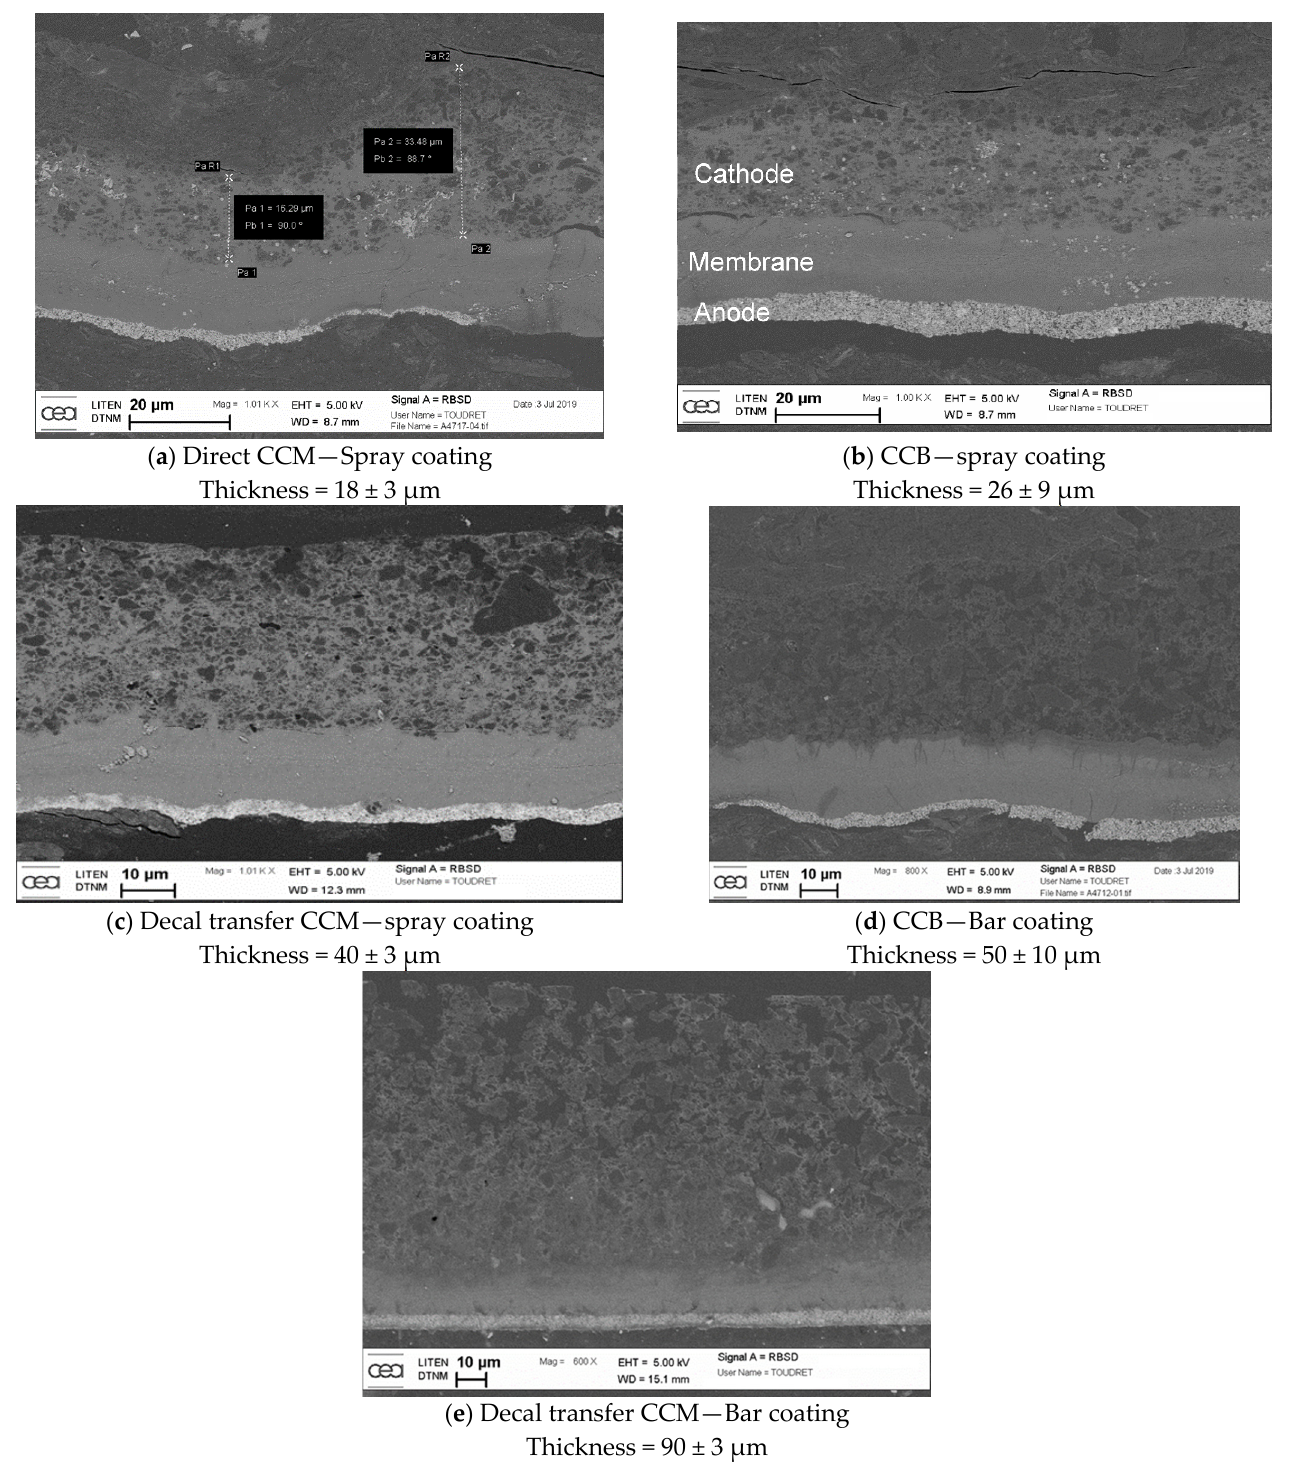
Figure 4. Comparison of process fabrication of CEA Pajarito MEA (anode: TKK 0.1–0.2 mgPt/cm 2 ; cathode: Pajarito 2 mg/cm 2 ). ( a – e ): SEM observation of MEA cross section, process used and cathode active layer